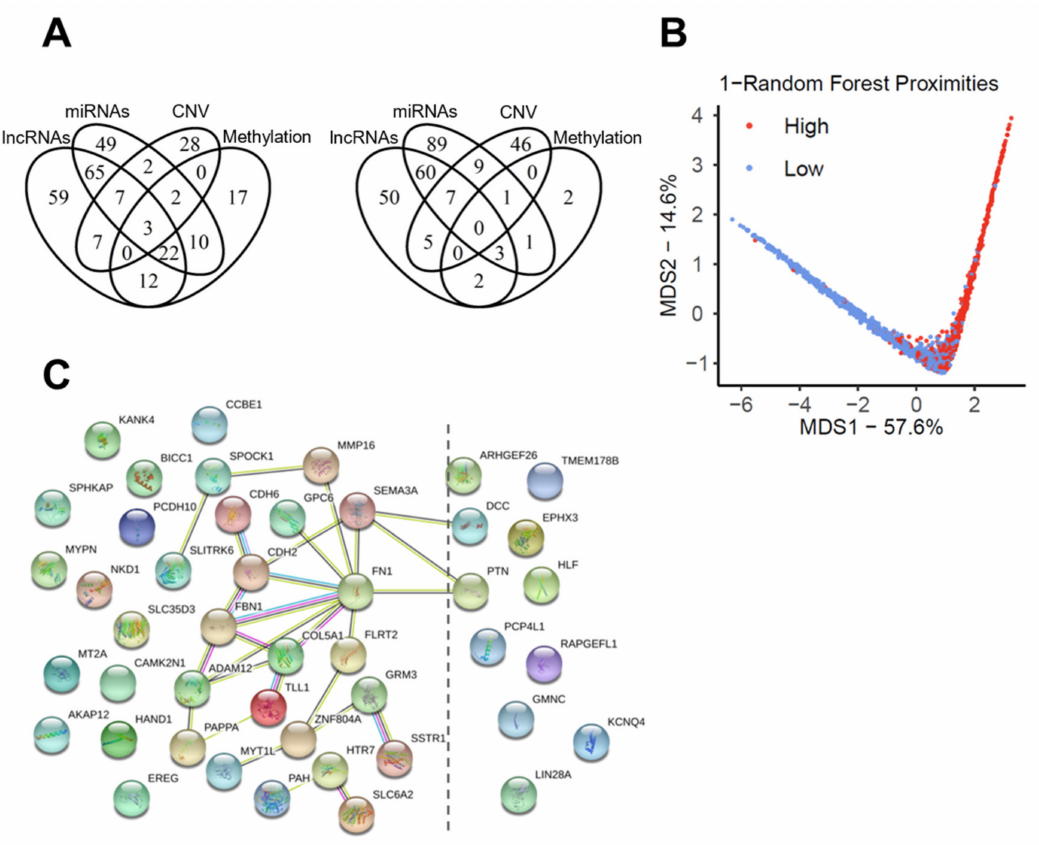
Figure 5. Candidate genes affected by different modes of genetic and epigenetic regulation. ( A ) Venn diagrams show the amount of DEGs with higher expression in either the high-risk (left) or the low-risk (right) group of the pan-SCC cohort, which are affected by different modes of indicated genetic (CNV) or epigenetic (Methylation, miRs, lncRNAs) events. ( B ) Random forest MDS plot presents distinct features of risk groups based on DEGs ( n = 45), which are affected by three out of four genetic and epigenetic events. ( C ) Schematic presentation of a protein–protein interaction network (minimum required interaction score: medium confidence (0.400)) for selected DEGs ( n = 45), which are affected by at least three out of four genetic or epigenetic events according to the STRING